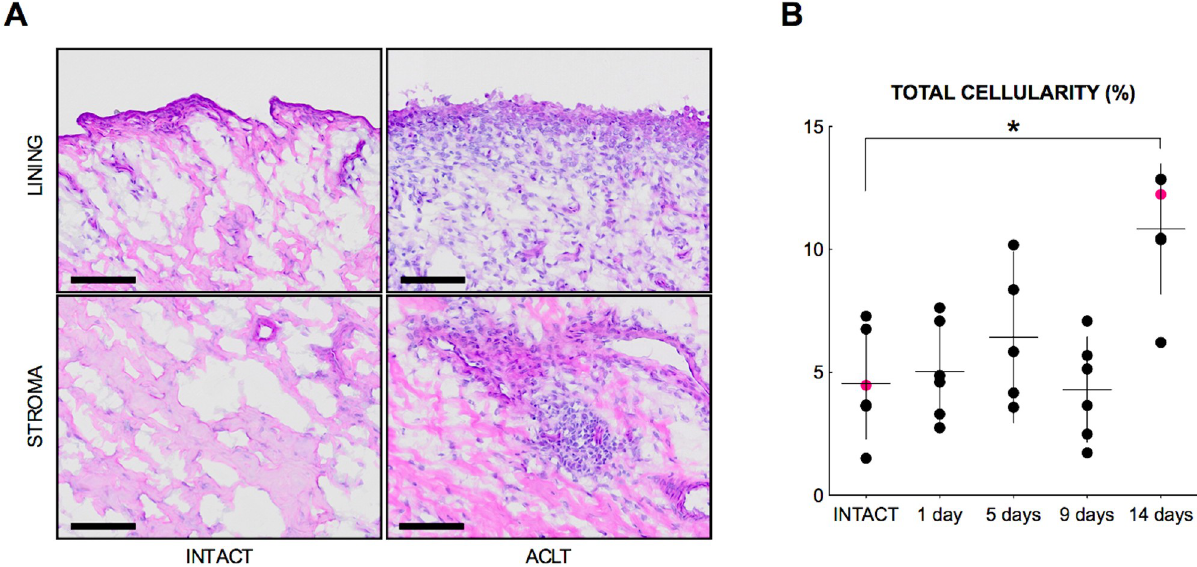
Fig 4. Histologic response of synovium to joint injury. (A) Photomicrographs of synovial biopsies obtained from intact controls and from knees at 14 days following injury, demonstrate an increased total cellularity at 14 days post-injury. Bars = 100 μ m. (B) Symbols represent individual specimens, horizontal lines indicate the mean, and vertical bars indicate 95% confidence intervals. Magenta dots are corresponding to the selected photomicrographs, i.e. representing the median total cellularity of the respective time-points. � p < .05.